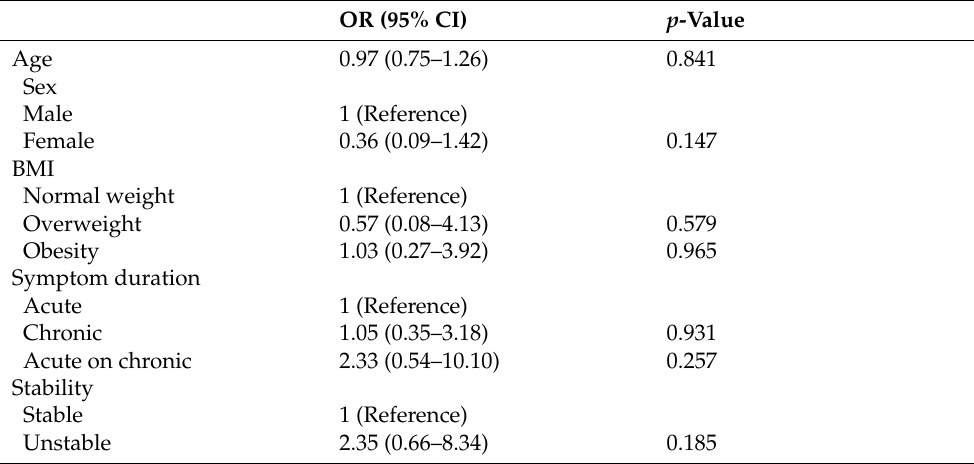
Table 3. Univariate analysis affecting slip